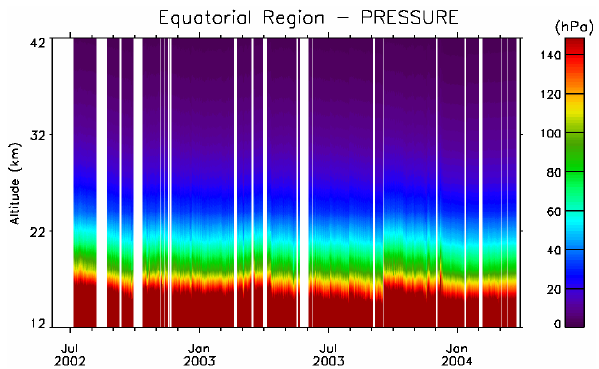
Fig. 6. Time series of FR daily mean pressures within the equatorial latitude band (20 ◦ S–20 ◦